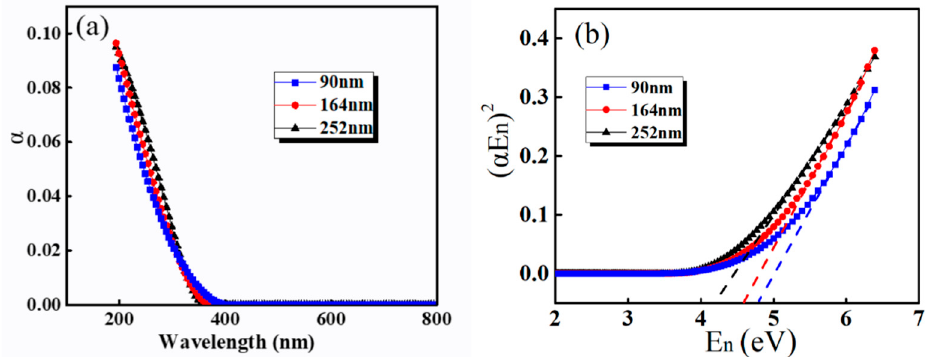
Figure 6. ( a ) absorption coefficient α and ( b ) the plot of ( α hv ) 2 vs. hv for PZT film with different thickness. Table 1. The values of the analytical parameters from the Tauc-Lorentz model for PZT film with different thickness.